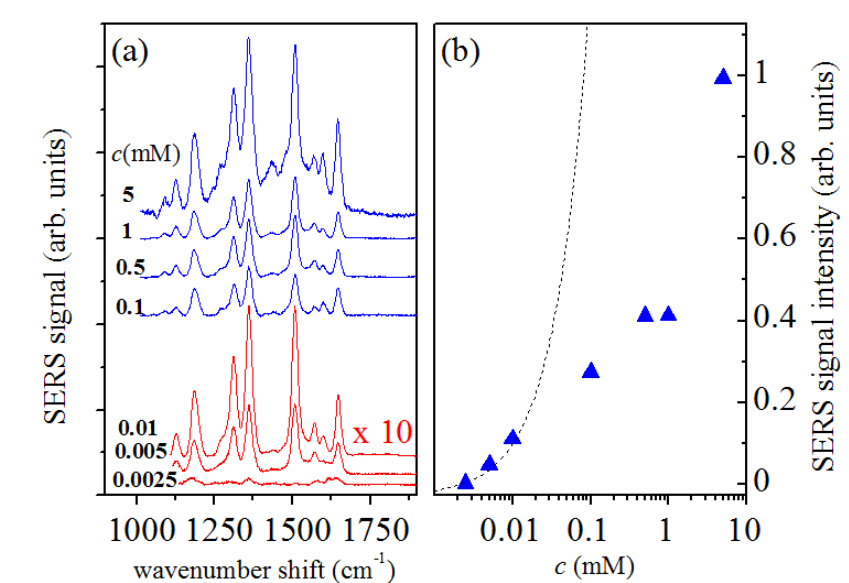
Figure 1. ( a ) SERS of Rhodamine aqueous solution at different concentration in the range of 0.0025–5 mM. The intensity of spectra reported in red are amplified by a factor 10. The spectra are reported arbitrarly shifted along the y-axis. ( b ) dependence of SERS signal intensity (SERS mode at 1504 cm − 1 ) on the Rhodamine 6G concentration (log scale). The linear dependence is represented by the dotted